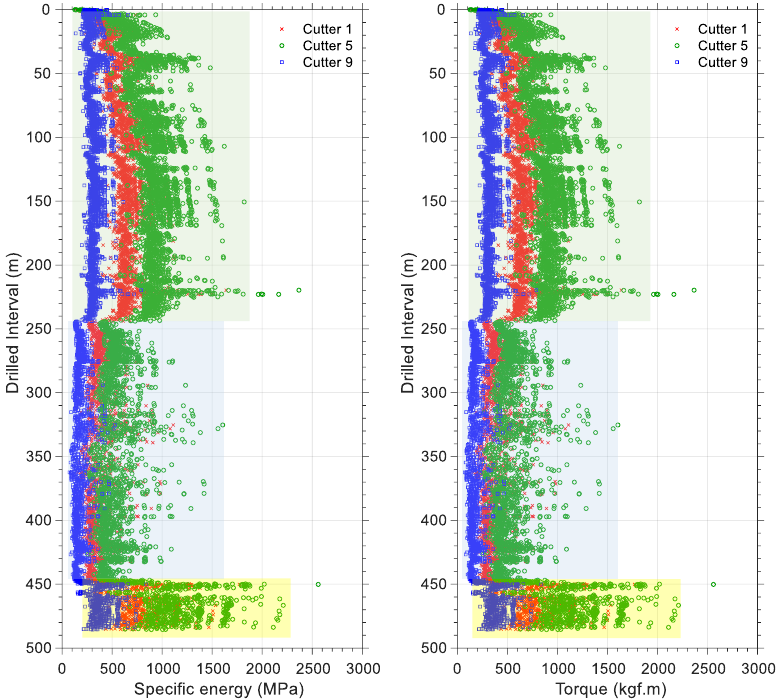
Figure 17. Specific energy ( left ) and torque ( right ) plots at the bit during bit run number